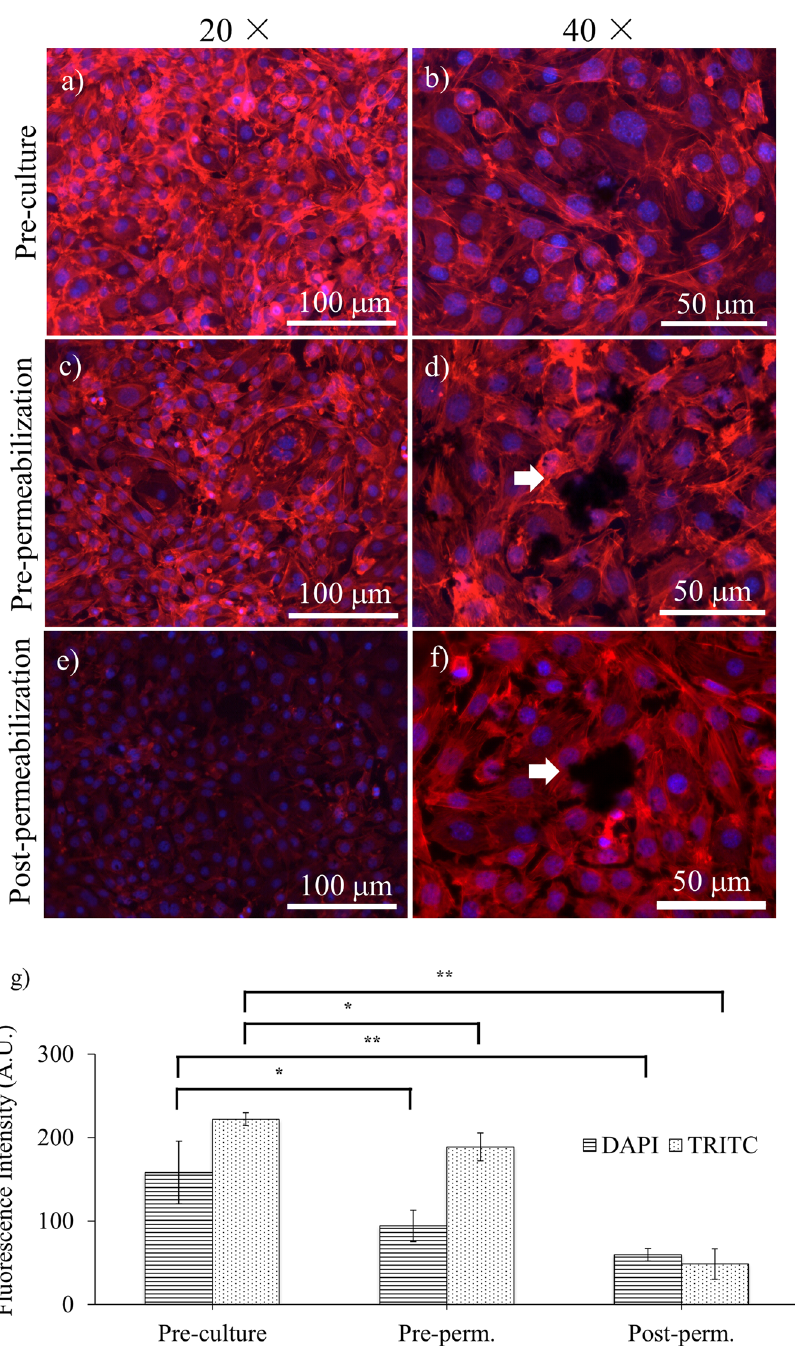
Figure 8. The comparison of three different SBB treatment schemes. The fluorescence images of C2C12 on planar PCL slabs after 3 days of cell culturing. The PCL slabs were treated by ( a , b ) pre-culture SBB treatment; ( c , d ) pre-permeabilization SBB treatment; and ( e , f ) post-permeabilization. The white arrows in ( d ) and ( f ) indicate dark particles on top of cells. The images in ( a , c , e ) were acquired with the same exposure time, analog gain, and lookup tables (LUTs) setting to ensure the fluorescence intensities in different images are comparable. The exposure time, analog gain, and lookup tables (LUTs) setting in ( b , d and f ) were adjusted to ensure the best brightness and contrast for analysis. ( g ) Statistical analysis of the fluorescence intensities of F-actins and cell nuclei obtained by the three treatment schemes. The cells were stained by rhodamine-phalloidin and DAPI on Day 3 of cell culturing with the growth medium. Red denotes F-actins; and blue denotes cell